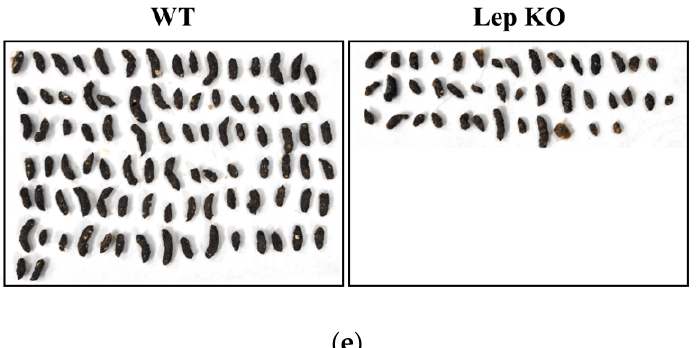
Figure 2. Incidence of constipation. The number ( a ), weight ( b ), and water contents ( c ) of the stool were measured from eight to 24 weeks, as described in the Materials and Methods; ( d ) The incidence of constipation was calculated based on the number of constipated mice and total mice used during 16 weeks, as described in Materials and methods; ( e ) The morphology of stools was observed using a digital camera. Five to six mice per group were used for the stool sample collection, and each parameter was assayed in duplicate. The data are reported as the mean ± SD. * indicates p < 0.05 compared to the WT mice. Abbreviations: WT, Wild type; KO, Knockout type.